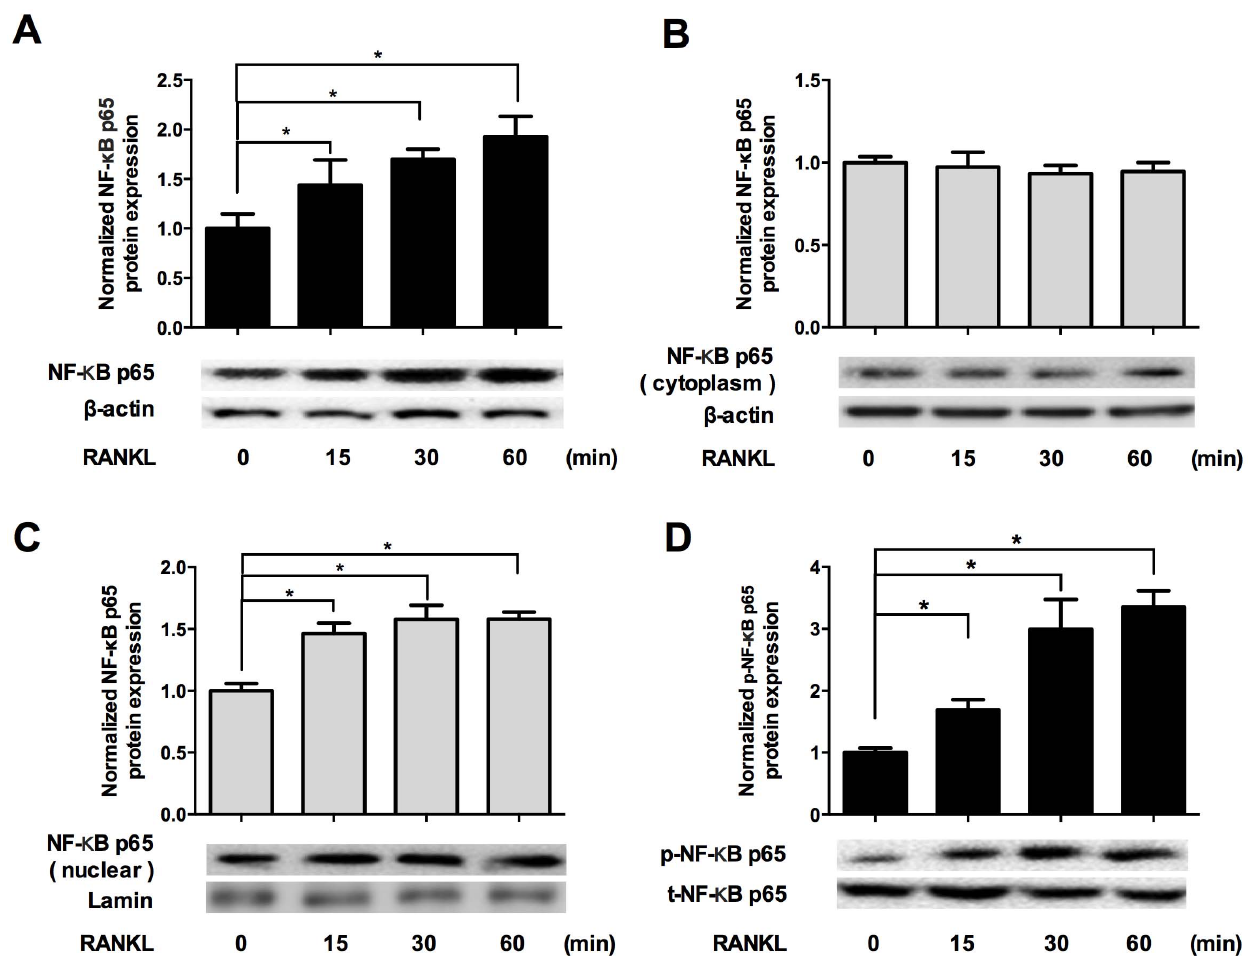
Figure 3. RANKL activated the NF- k B pathway in HCC cells. HepG2 cells were incubated with 100 ng/ml RANKL for 0, 15, 30 and 60 minutes. A. Western blot analysis indicated that total NF- k B p65 protein was up-regulated significantly upon RANKL treatment in a time-dependent manner. B. Treatment with RANKL did not change the expression of NF- k B p65 in cytoplasm as incubation time prolonged. C. RANKL stimulation significantly increased the expression of NF- k B p65 in the nucleus in a time-dependent manner. D. Western blot analysis revealed that phosphorylation of NF- k B p65 increased in a time-dependent manner upon RANKL treatment. * p , 0.05 compared with 0 min group.